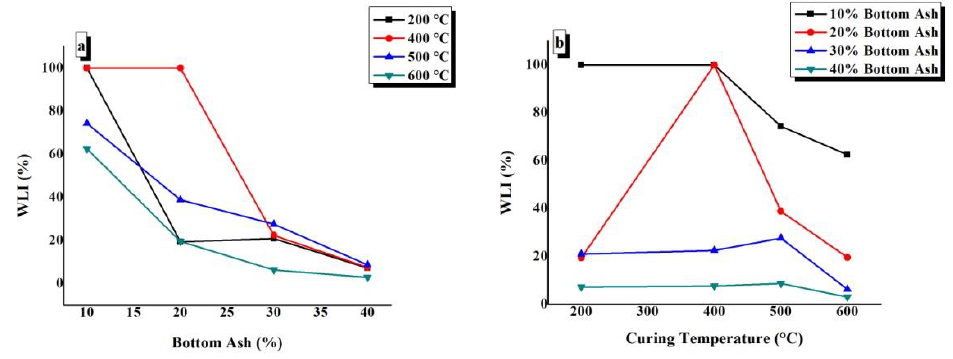
Figure 10. E ff ect of ( a ) bottom ash content and ( b ) curing temperature on the WLI of Figure 10. Effect of ( a ) bottom ash content and ( b ) curing temperature on the WLI of TGPFs.